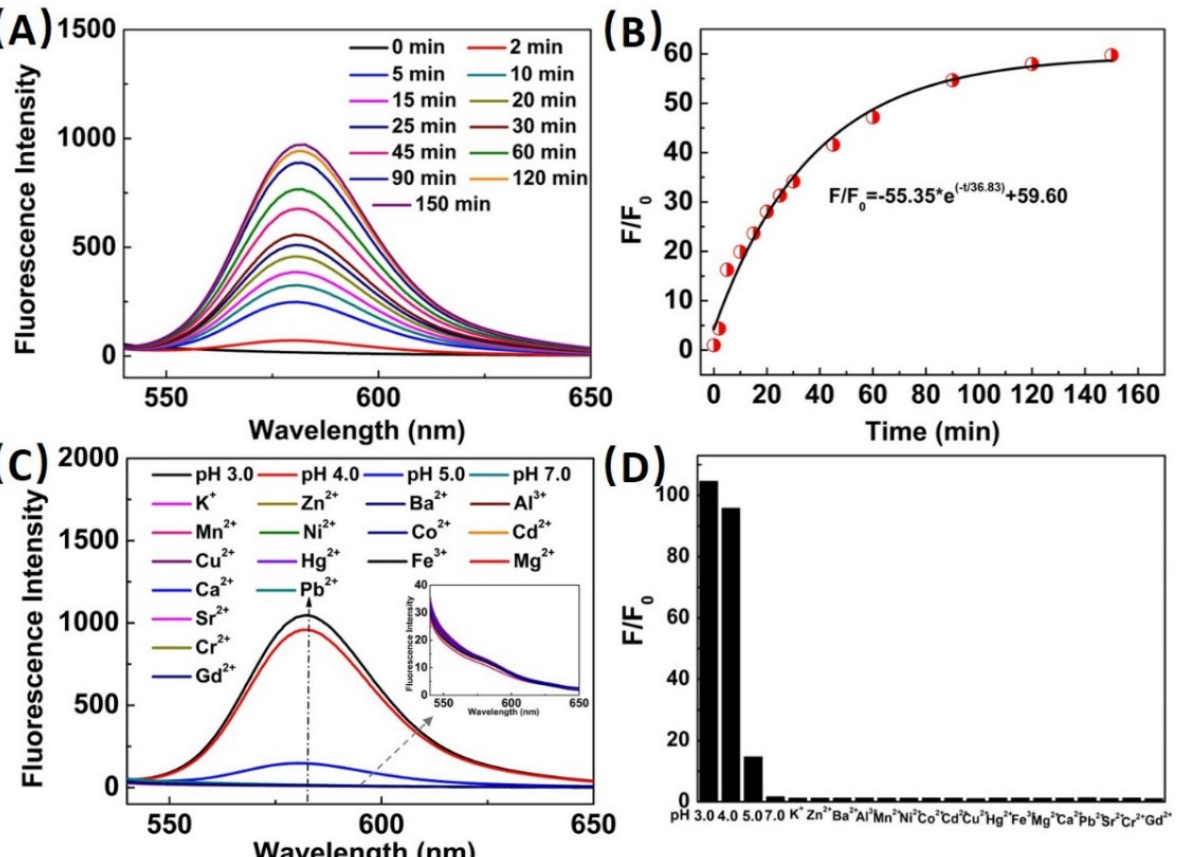
Figure 7. ( A ) The time variation of fluorescence spectra recorded for a rhodamine-functionalized mPEG-b-P(PA-alt-AGERh) copolymer micelles solution (1.5 mg/mL) at pH 3.0; ( B ) The time variation of fluorescence intensity at 582 nm recorded for the micelle solution of rhodamine-functionalized mPEG-b-P(PA-alt-AGERh) (1.5 mg/mL) at pH 3.0; ( C ) Fluorescence spectra recorded for a rhodamine-functionalized mPEG-b-P(PA-alt-AGERh) copolymer micelles solution (1.5 mg/mL) at different pH or in the presence of different kinds of metal ions (tris-buffer pH 7.0, 100 µ M); the inserted graph showing the enlarging form of the fluorescence spectra recorded for those treated with metal ions; and ( D ) Relative fluorescence intensity at 582 nm recorded for the micelle solutions of rhodamine-functionalized mPEG-b-P(PA-alt-AGERh) (1.5 mg/mL) at different pH or upon addition of 100 µ M of various metal ions (tris-buffer pH